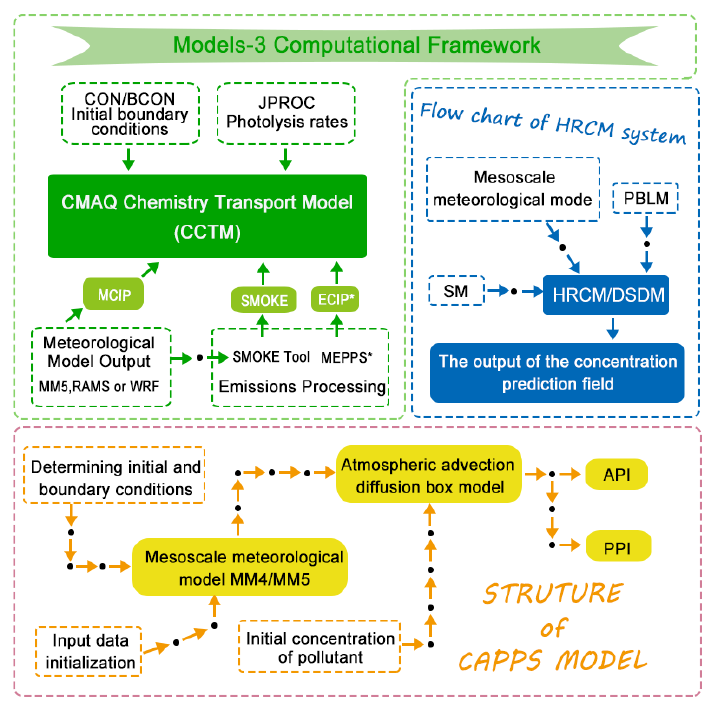
Figure 6. Structures of numerical forecast methods.